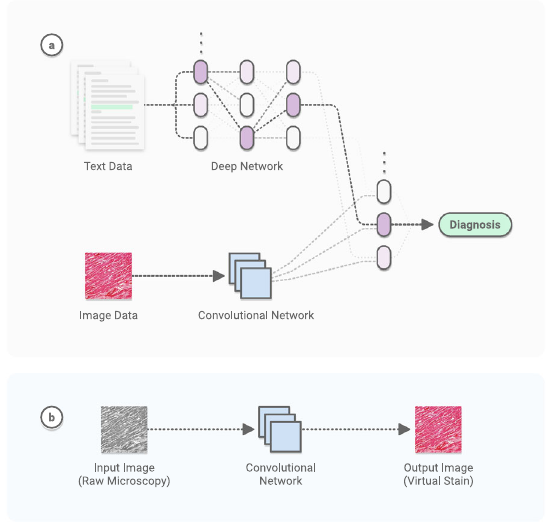
Fig. 1 Example medical computer vision tasks. a Multimodal discriminative model. Deep learning architectures can be con- structed to jointly learn from both image data, typically with convolutional networks, and non-image data, typically with general deep networks. Learned annotations can include disease diagnos- tics, prognostics, clinical predictions, and combinations thereof. b Generative model. Convolutional neural networks can be trained to generate images. Tasks include image-to-image regression (shown), super-resolution image enhancement, novel image gen- eration, and others.